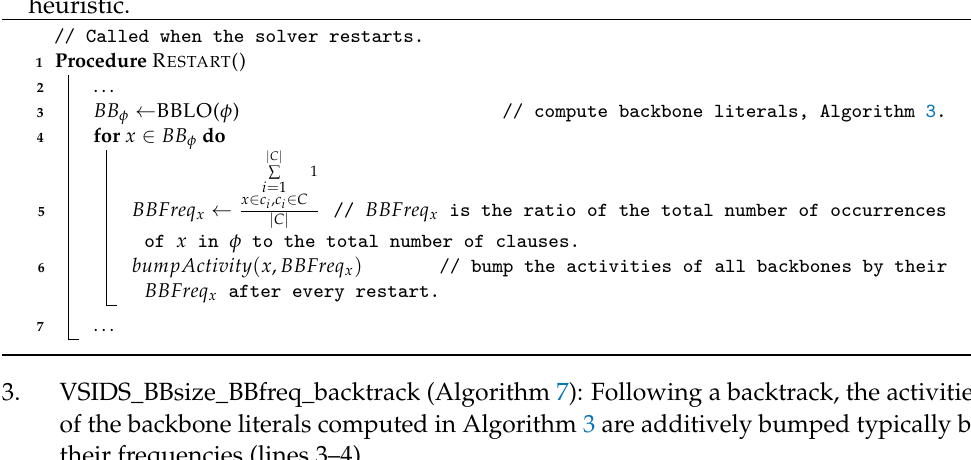
Algorithm 6: VSIDS_BBsize_BBFreq_restart a variant of the VSIDS decision heuristic.